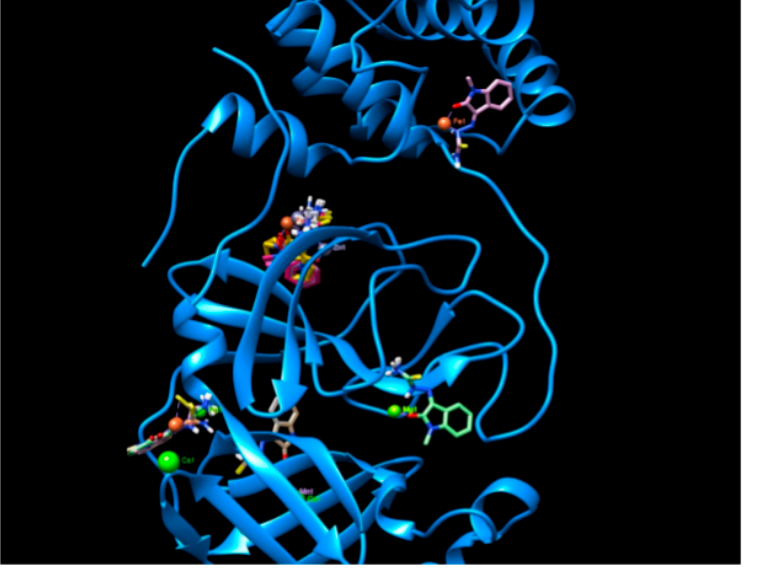
Figure 4. Visualization of five docking sites in 6Y2E_A. Two docking sites have single occupancy (Fe and Mg), one has two occupants (Ca and Mn) and the other two can be occupied by all metal complexes. Molecular graphics and analyses performed with UCSF Chimera, developed by the Resource for Biocomputing, Visualization, and Informatics at the University of California, San Francisco, with support from NIH P41-GM103311.